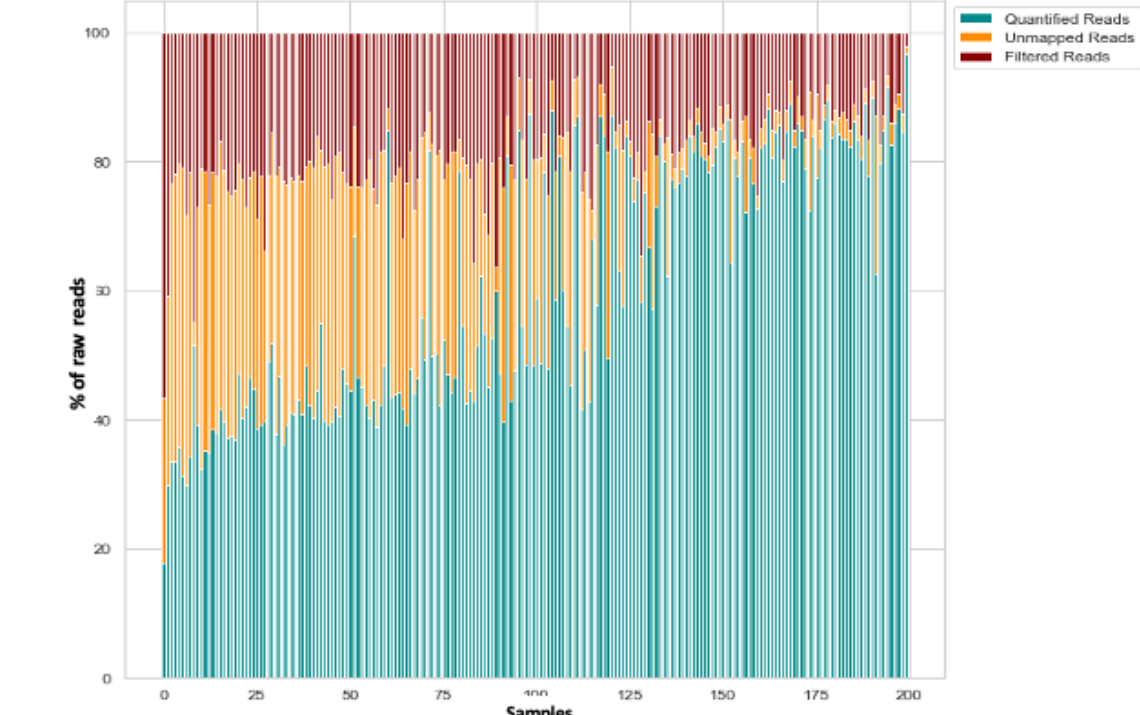
Figure 2. Overall composition of processed reads for plasma samples. In green: quantified reads ; In Yellow: Unmapped reads ; In Red: Filtered reads.